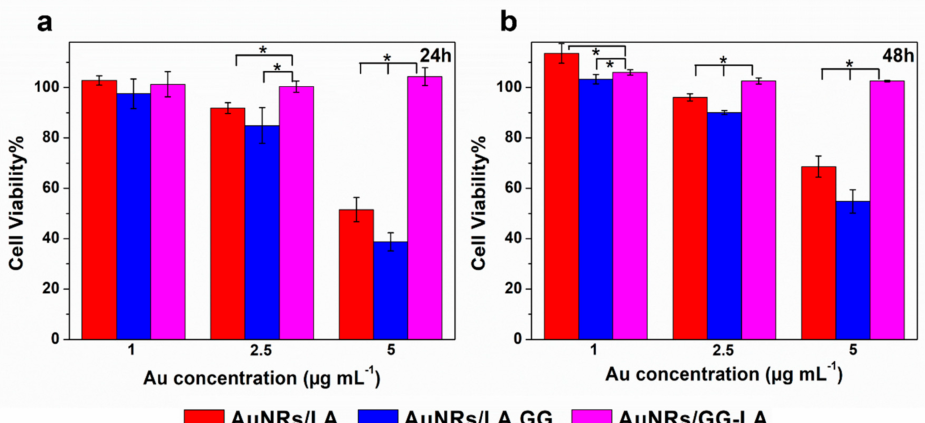
Figure 7. Cell viability of human colorectal cancer cell line (HCT116) line after 24 h ( a ) or 48 h ( b ) incubation with AuNRs / LA (red), AuNRs / LA,GG (blue), and AuNRs / GG-LA (fuchsia) at gold concentrations of 1, 2.5, and 5 µ g · mL − 1 . Statistical significance (Student’s two-tailed t test): * p <